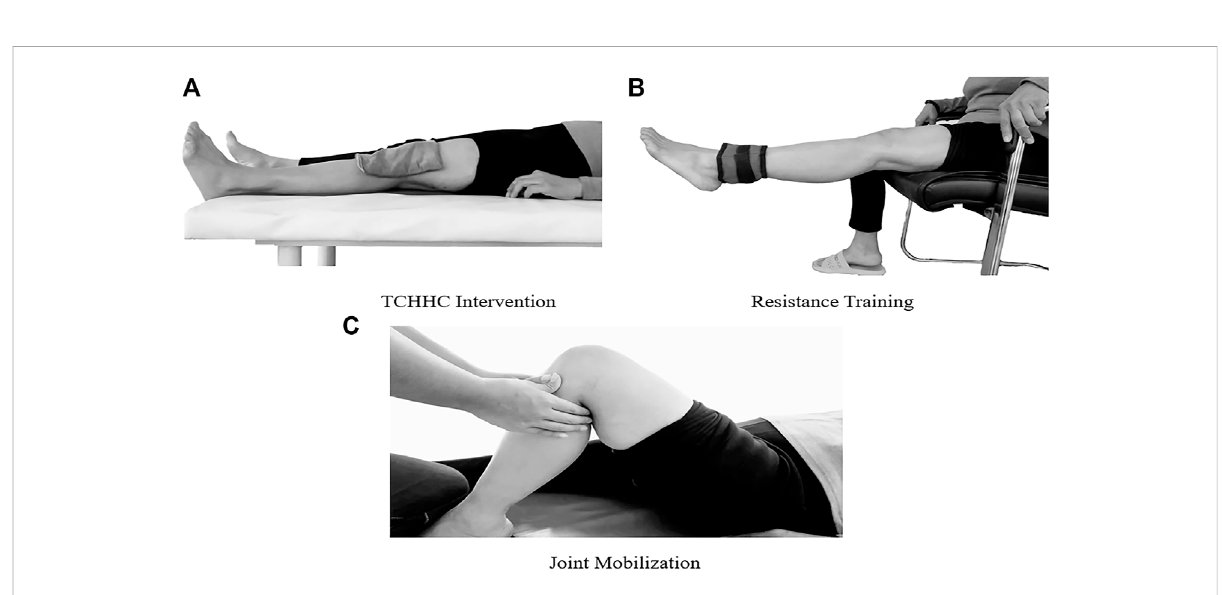
FIGURE 2 Illustrations of TCHHC (A) , resistance training (B) , and joint mobilization (C)